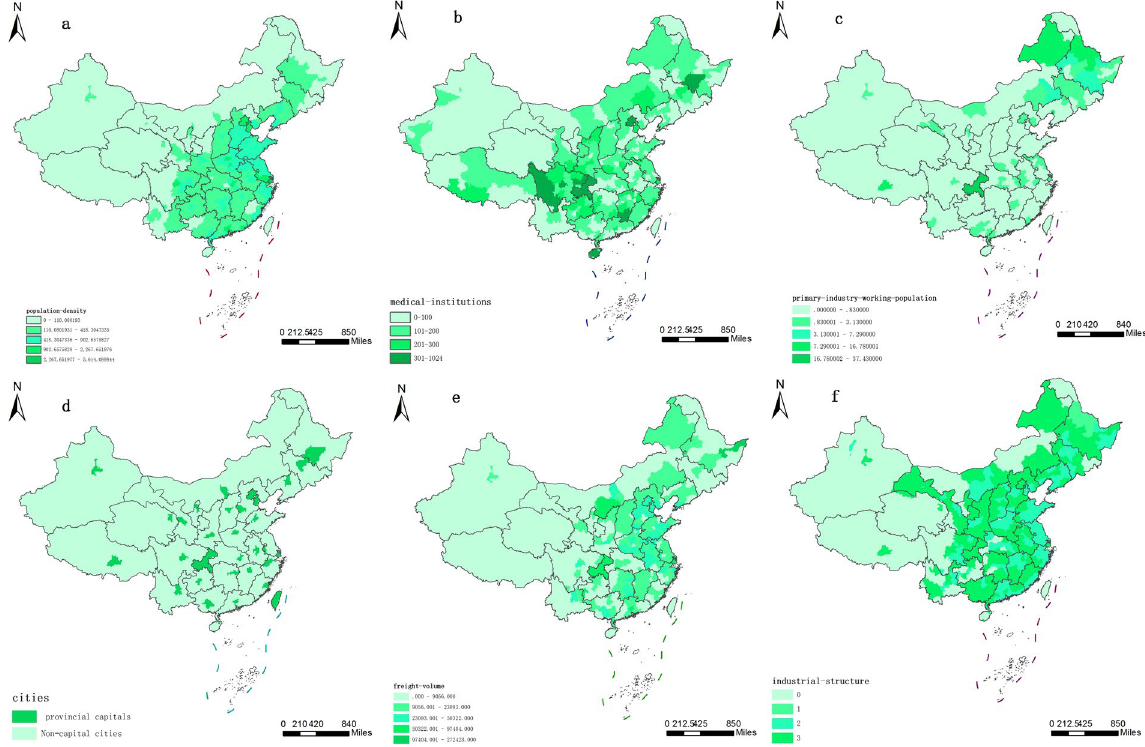
Figure 7. Socioeconomic variable data (( a ) (population-density) National total population density map, ( b ) (medical-institutions) Distribution map of national medical institutions at and under the township level, ( c ) (primary-industry-working-population) primary industry personnel, ( d ) (cities) Distribution map of provincial capitals, ( e ) (freight-volume) Distribution map of freight tonnage, ( f ) (industrial-structure) Industrial structure data, including percentage of employees in primary, secondary and tertiary industries. Maps created in ArcGIS 10.2 (Environmental Systems Resource Institute, ArcMap Release 10.2, Environmental Systems Resource Institute, ArcMap Release 10.2, ESRI, Redlands,